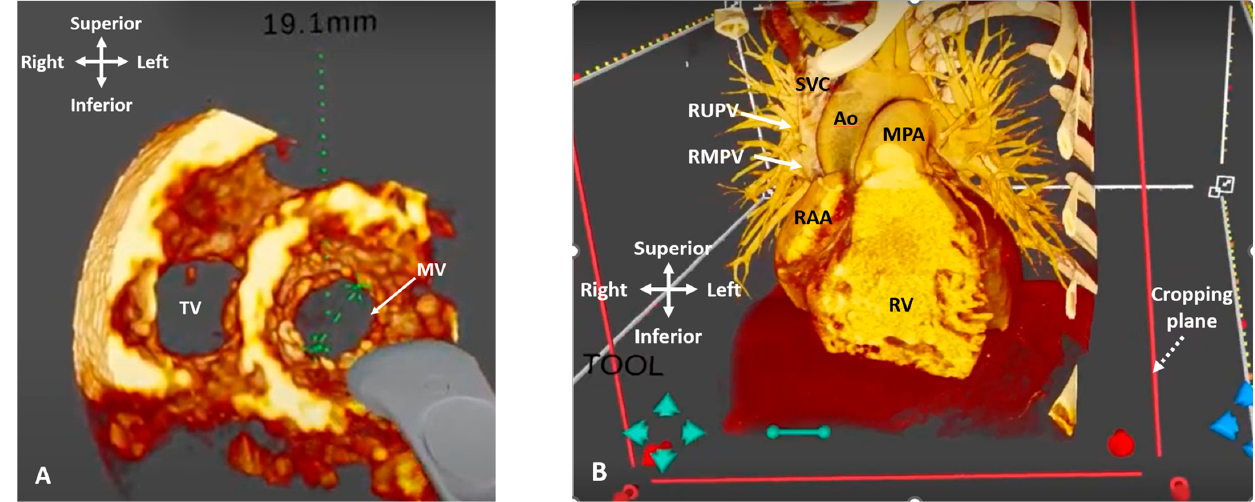
Figure 13. Three-dimensional rendered imaging in virtual reality. ( A ) 3D TOE image viewed from ventricular apex, demonstrating view of the mitral and tricuspid valves. A measurement of the mitral valve annulus has been performed using the in-built tool. ( B ) CT demonstrating a case of Superior Sinus Venosus ASD. The cropping plane (dashed arrow) is cropping into the volume from the anterior plane and demonstrating the entry points of the RUPV and RMPV into the SVC (arrows). Ao: Aorta; MPA: Main pulmonary artery; MV: Mitral valve; RAA: Right atrial appendage; RMPV: Right middle pulmonary vein; RUPV: Right upper pulmonary vein; RV: Right ventricle; SVC: Superior vena cava; TV: Tricuspid valve.